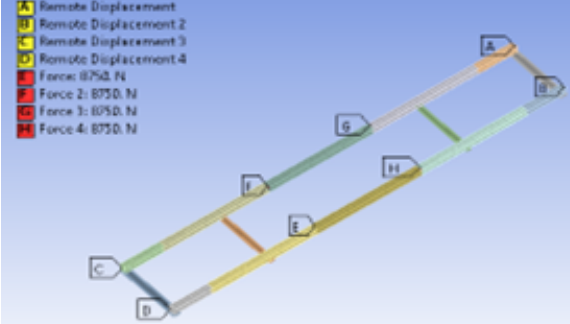
Fig. 3. Boundary condition of I-beam ladder frame